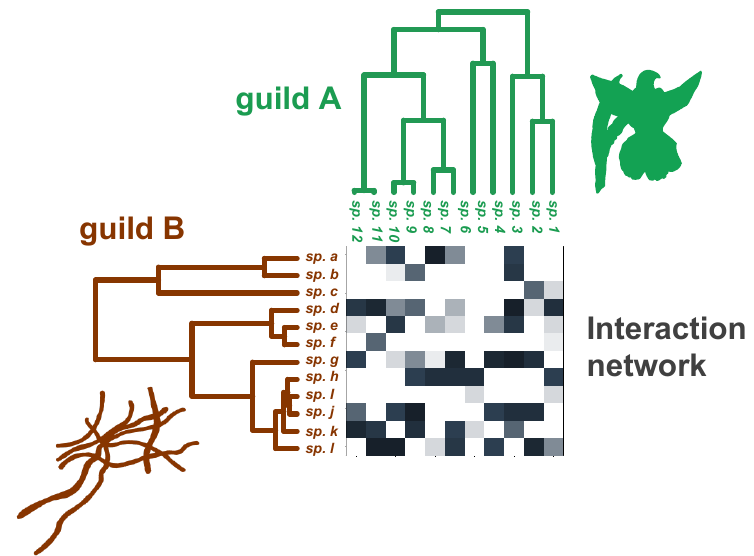
Figure 1: Illustration of the data used to test for phylogenetic signal in species interactions Toy example of an interaction network between orchids (in green) and mycorrhizal fungi (in brown) with associated phylogenetic trees. The bipartite interaction network between two guilds A (here the orchids) and B (the fungi) is represented by a matrix, which elements indicate either whether or not species interact ( i.e. 1 if they do and 0 otherwise, “unweighted” or “binary” network) or the interaction frequency (“weighted” network; for example here we indicated the number of times a given pairwise interaction has been observed using shades of gray from white (no interaction) to dark gray (many interactions)). Each guild is also characterized by a rooted phylogenetic tree, used to compute phylogenetic distances between species